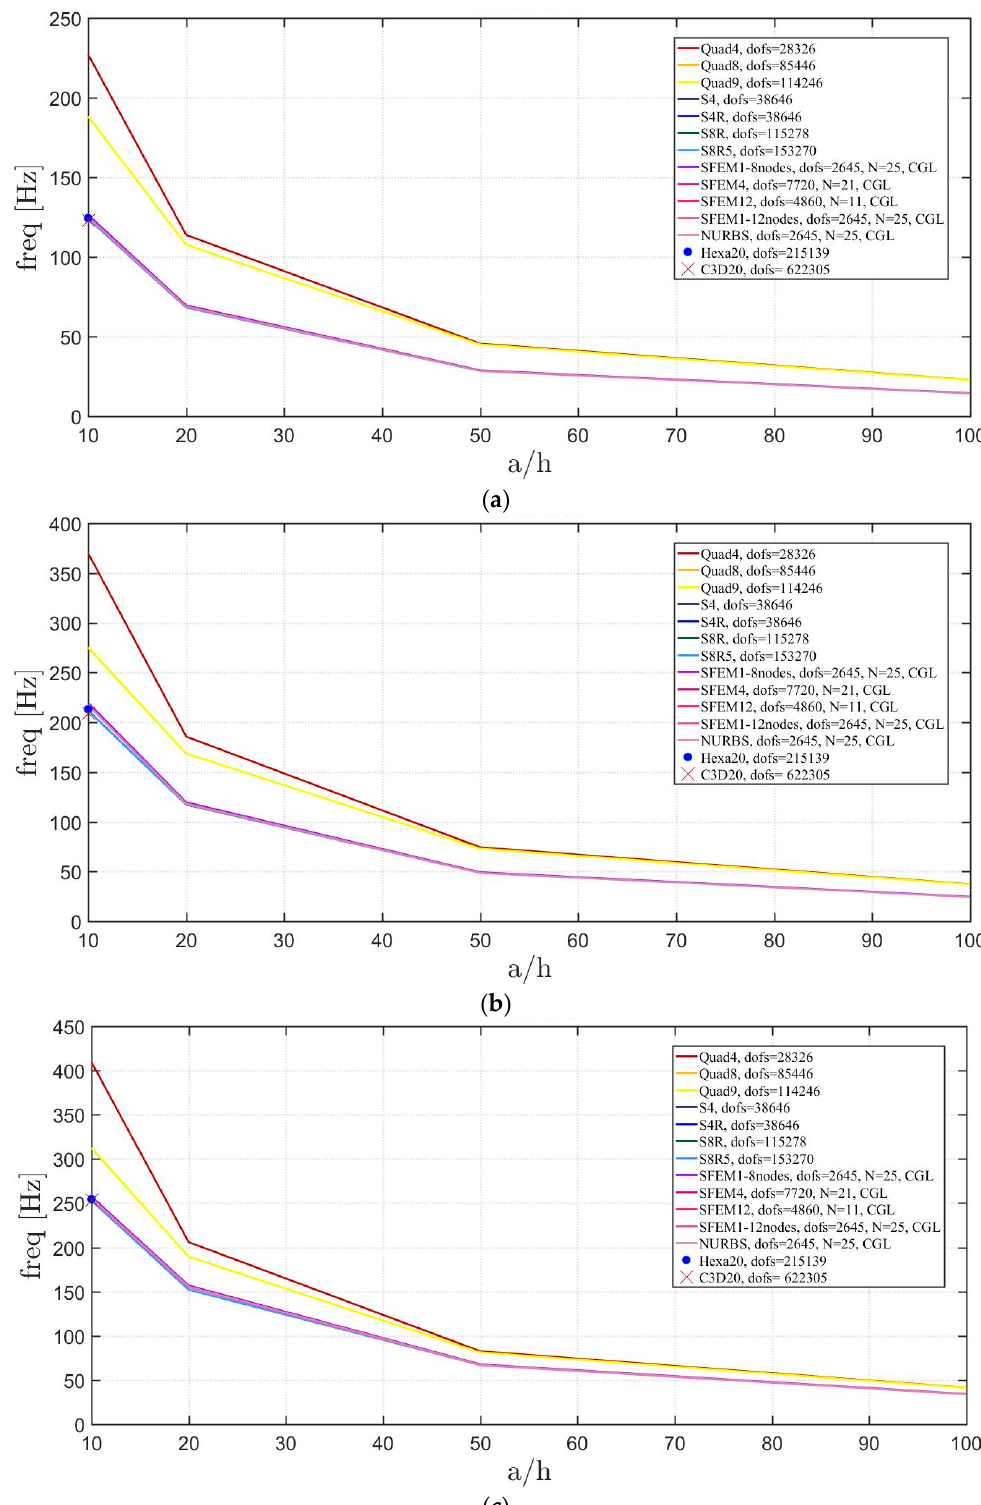
Figure 26. Thickness effect on the first three natural frequencies of an elliptic plate a / b = 1.5 with a symmetric lamination scheme: ( a ) First frequency; ( b ) Second frequency; ( c ) Third frequency.